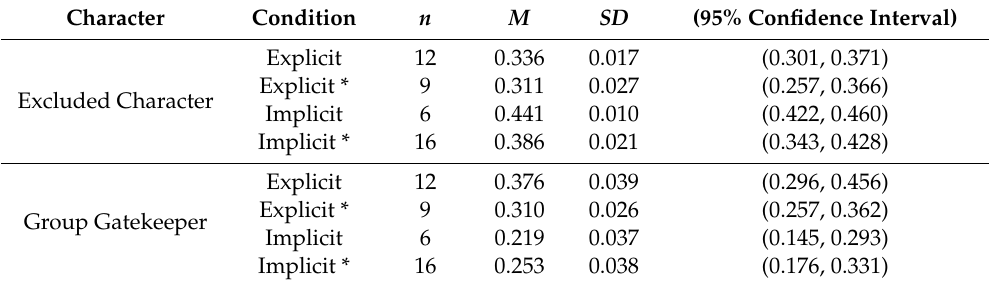
Table 6. Mean proportions of fixations on primary AOIs during exclusion trials by